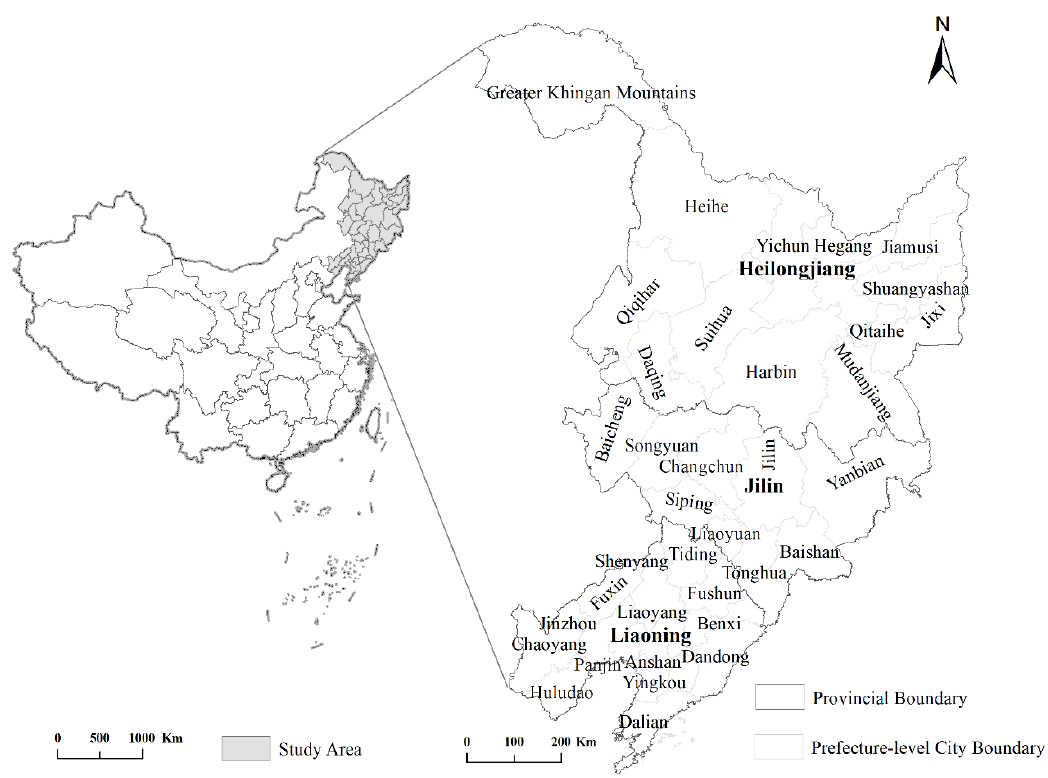
Figure 1. Study area in northeast China.